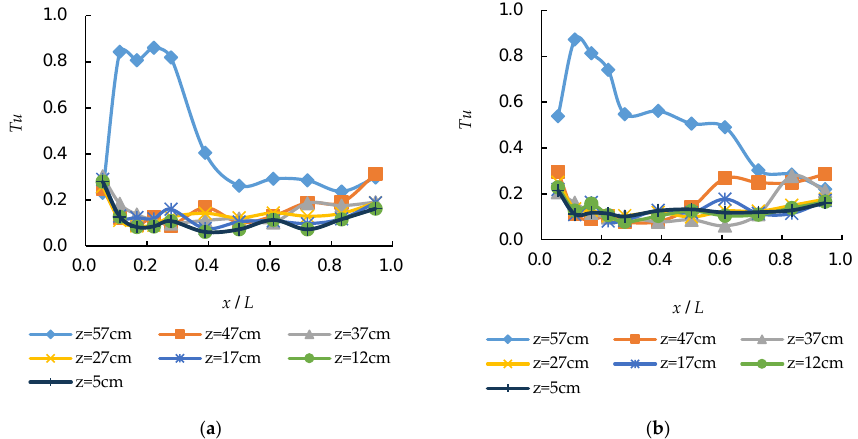
Figure 8 . Longitudinal turbulence intensity distribution.( a ) Q 1 = 20.79 L/s; ( b ) Q 2 = 30.04 L/s.